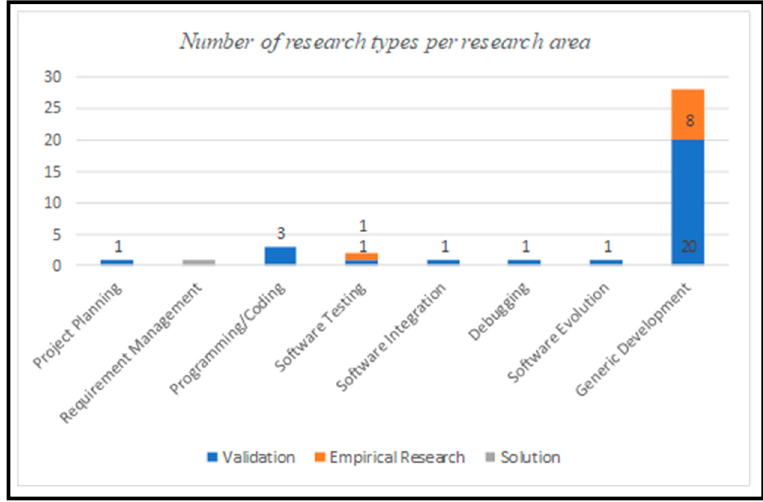
Figure 1. Research study types for each research area (software development). Figure 1 highlights the following points: